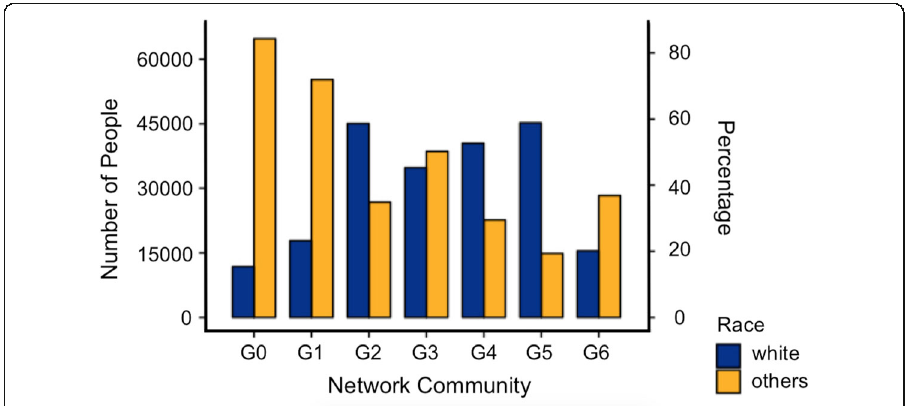
Fig. 2 The distribution of white and non-white population of Boston among different